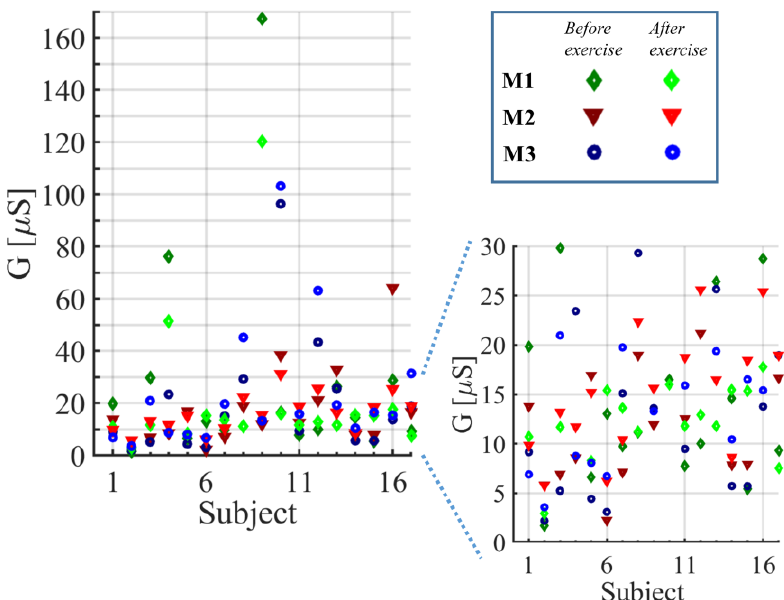
Fig. 5: Initial conductance values, G in , under each electrode (M 1 , M 2 , and M 3 ) shown for all 17 test subjects before and after exercise. The plot in the lower right corner is a zoomed in version of the plot to the